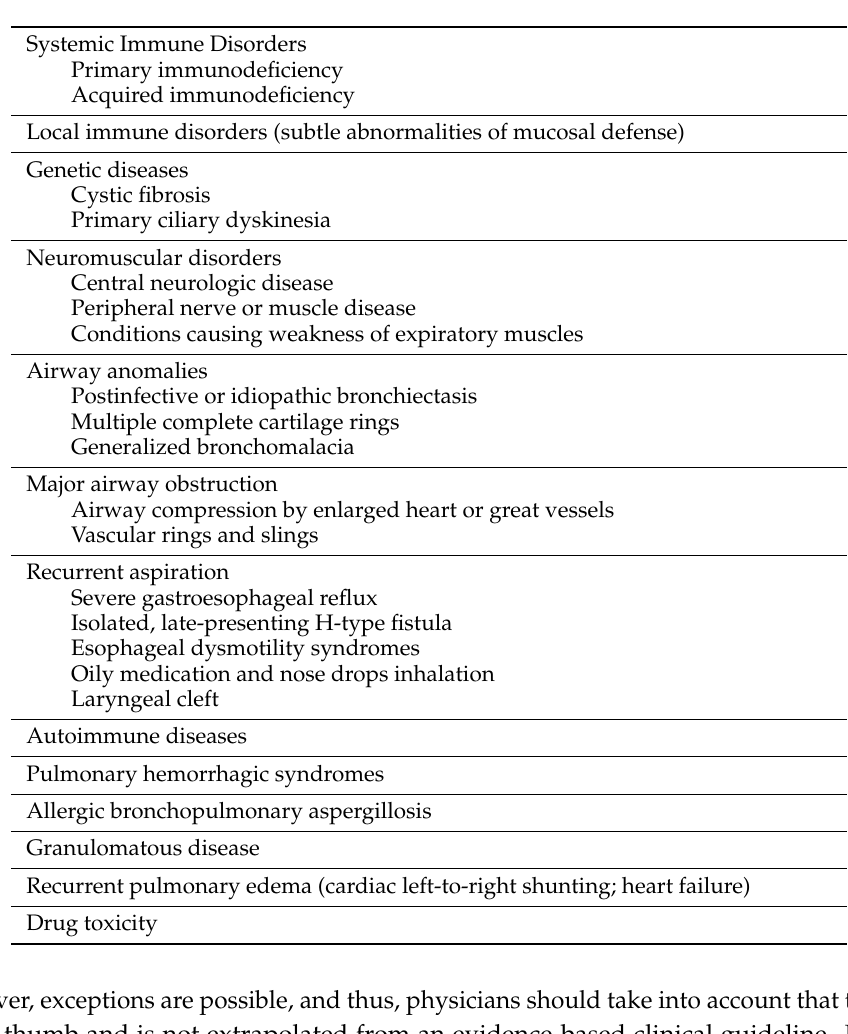
Table 4. Underlying causes of recurrent pneumonia affecting different/multiple lobes.